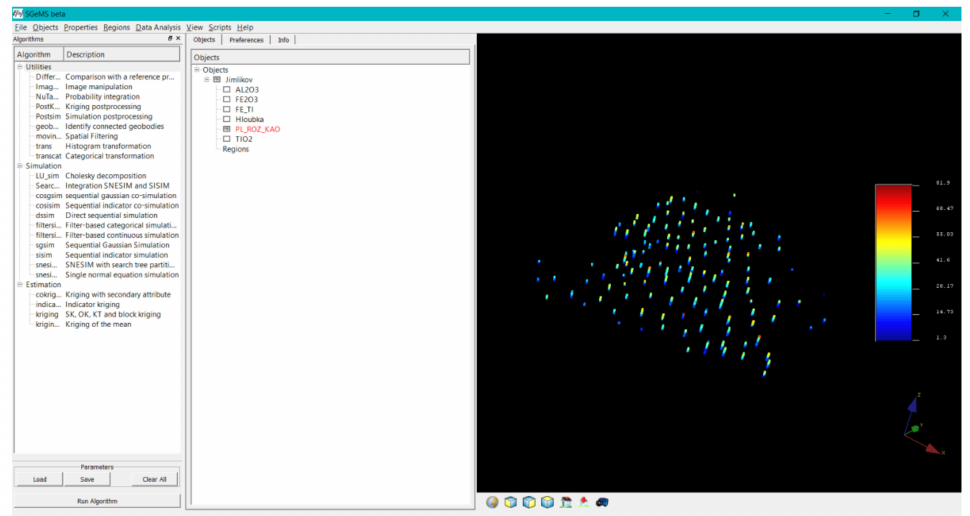
Figure 4. Example of visualization of data transferred to the SGeMS environment—the example presented depicts the visualization of kaolin